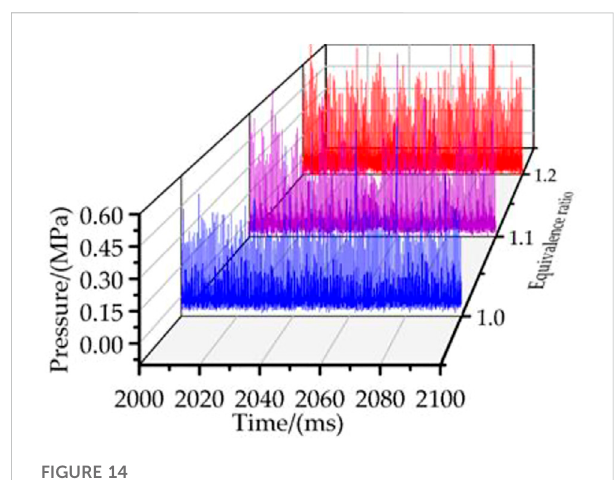
FIGURE 14 Comparison of pressure with different equivalent